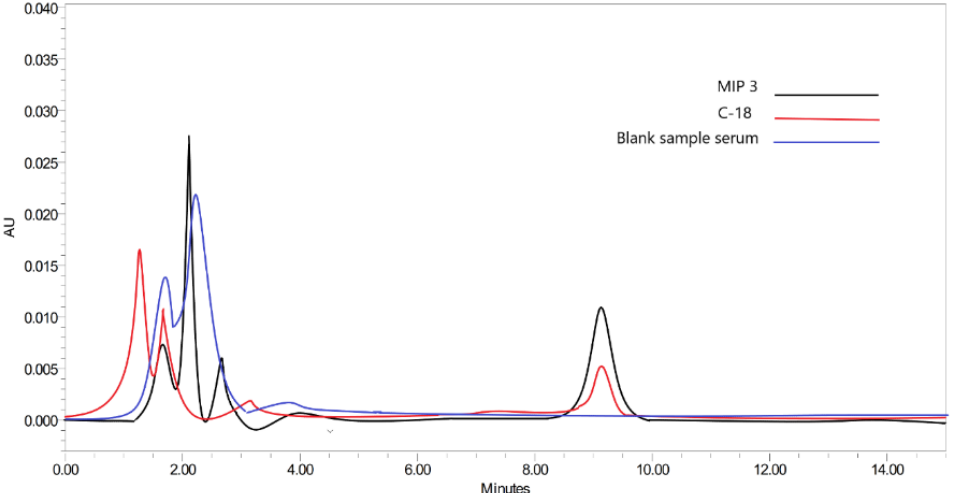
Figure 9. Chromatogram of SLX in serum pre-treated with MIP 3 and C-18 sorbent. 3.8. Physical Characterization of Sorbent with Brunauer-Emmett-Teller (BET), Scanning Electron Microscopy (SEM), and Fourier Transform Infrared (FTIR)